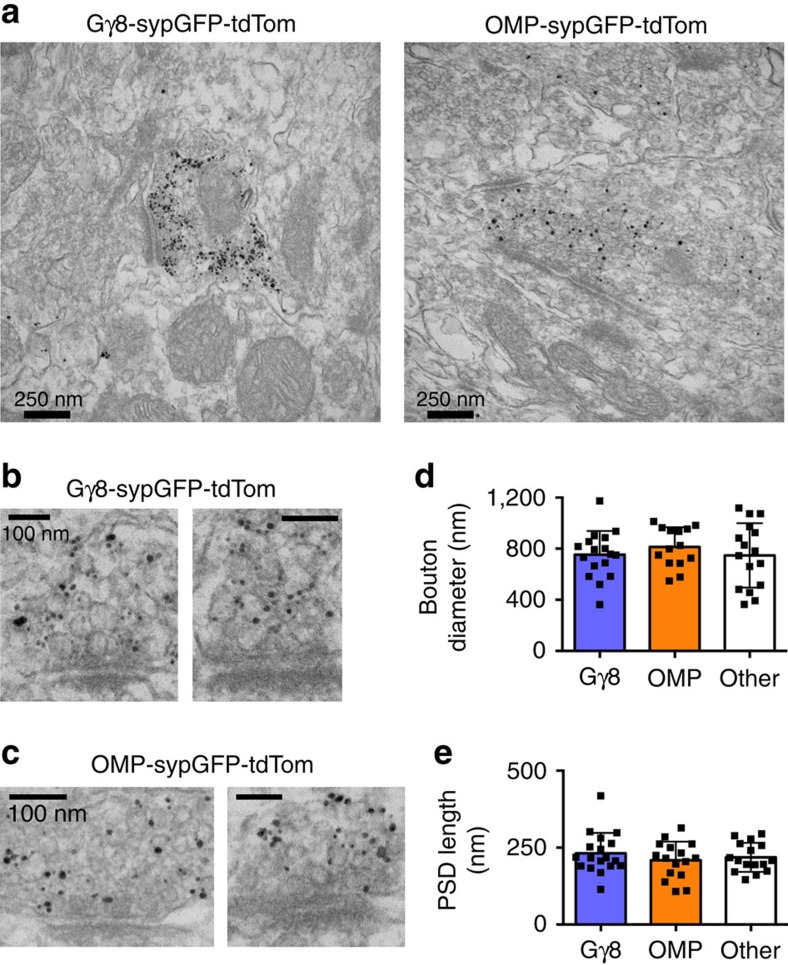
Immature OSN axons form synapses in the OB.(a) Low-magnification EM images from Gγ8-sypGFP-tdTom (left) and OMP-sypGFP-tdTom (right) mice demonstrating specific labelling of OSN presynaptic terminals with immunogold anti-GFP immunostaining. (b,c) Anti-GFP immunogold transmission electron micrographs of synapses formed by immature (b) or mature (c) OSN axons in the OB of 8-week-old mice. (d,e) No difference in maximum bouton diameter (d; P=0.36) or PSD length (e; P=0.55) between synapses formed by immature (n=18) or mature (n=16) OSNs or adjacent unlabelled synapses (‘other', n=16; one-way ANOVAs). Bar charts show mean±s.d.